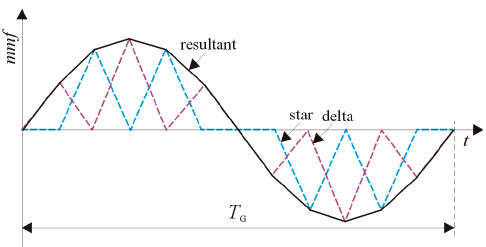
Figure 3. Theoretical shape of magnetomotive force ( mmf ) associated with group of “star” and “delta” connections and the resultant mmf .